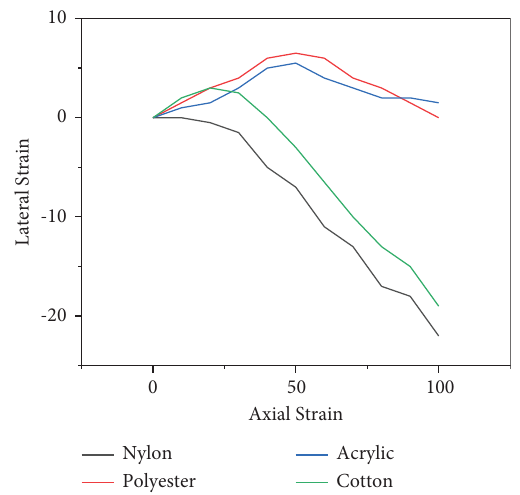
Figure 13: Course-wise expansion in zigzag structure on the ap- plication of force.